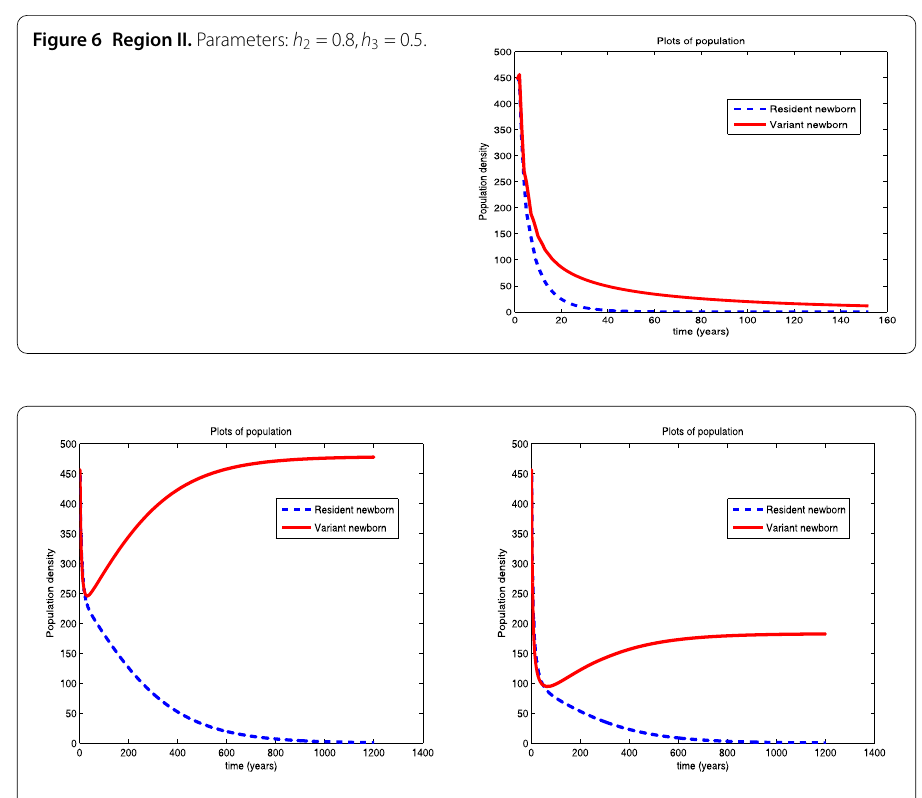
Figure 7 Region IIIa. Plot of newborn populations vs time. Parameters: h 2 = 0.5, h 3 = 0.8 on the left h 1 = 0 and on the right h 1 = 0.2.